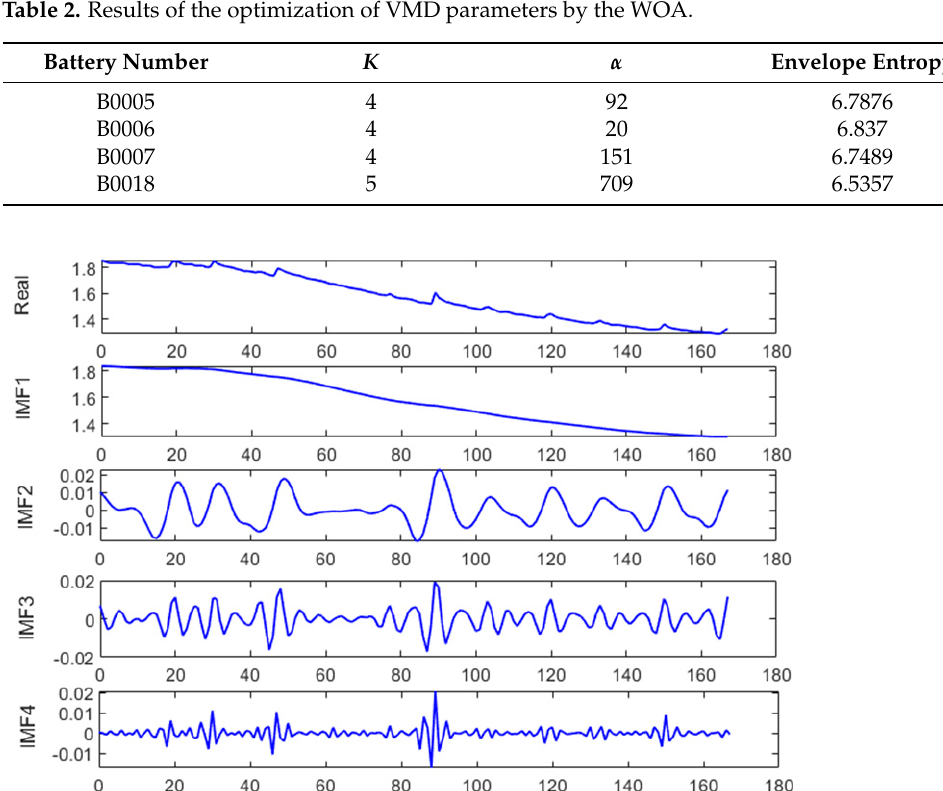
Figure 4. WOA-VMD results of B0005 battery capacity data. Table 3. Correlation coefficient between IMFS and measured capacity data for each battery Table 2. Results of the optimization of VMD parameters by the WOA.